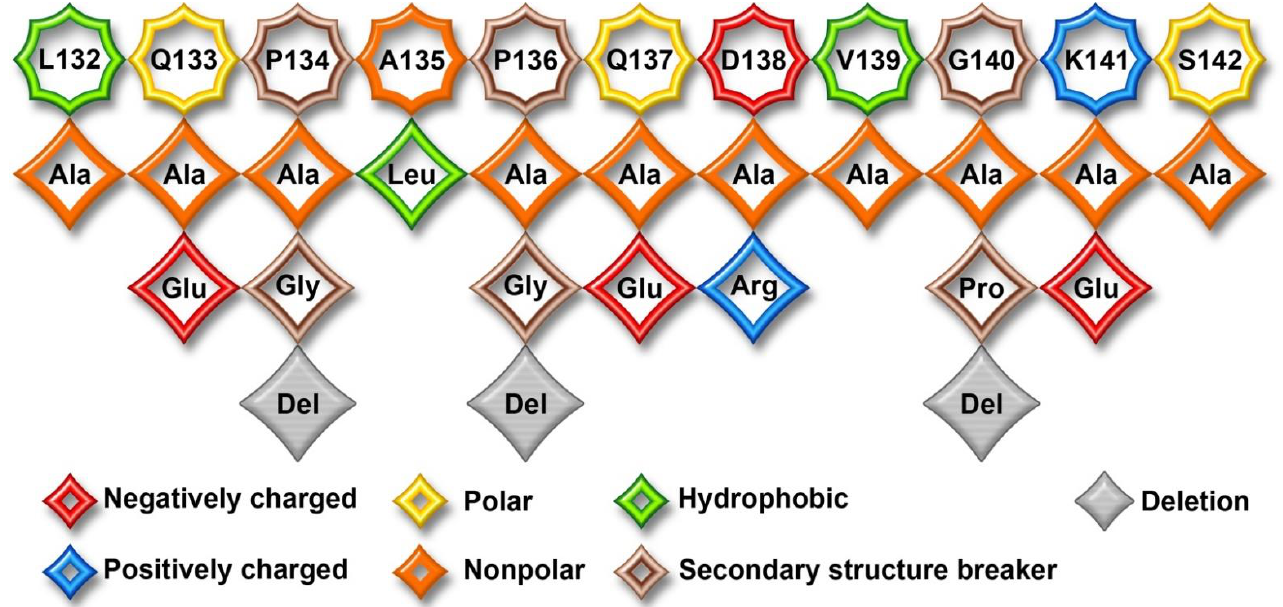
Figure 2. Middle loop in arrestin-1 and the mutants. Linear WT sequence of the middle loop of bovine arrestin-1 is shown on top, with residues as octagons. Substituting residues used in this study are shown as rhombi. The chemical nature of the original side chain and its replacements is shown by color, as indicated. Bulky hydrophobic residues were replaced with Ala and vice versa; charged residues were also replaced with Ala and a residue with the opposite charge; glutamines were replaced with Ala to remove the side chain and glutamic acid to introduce the charge without affecting the geometry; Gly and Pro that usually break the secondary structure were replaced by alanines (that are perfectly “happy” in any secondary structure), changed into each other, or deleted.